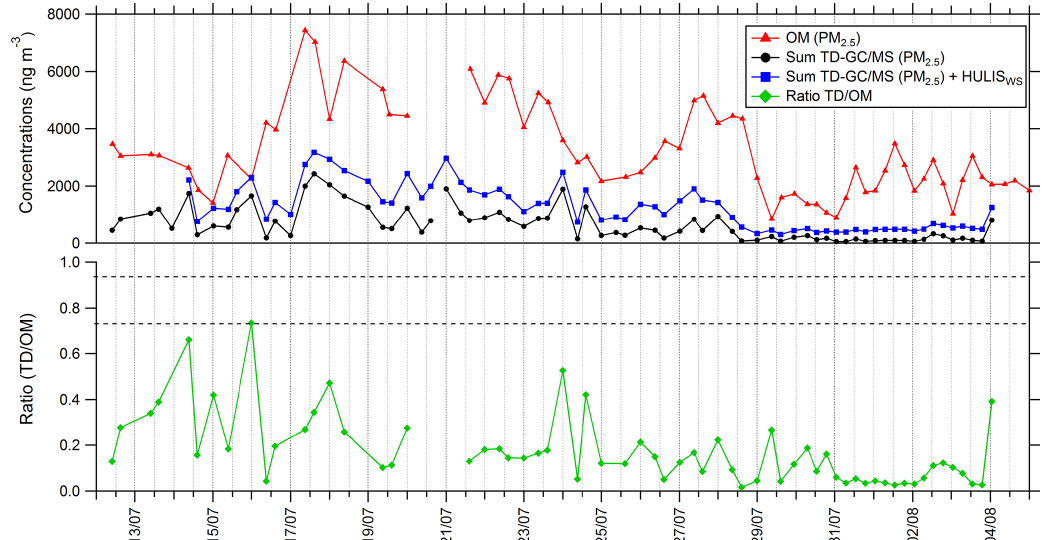
Figure 9. Time series of organic matter in PM 2 . 5 (red line), total sum of PM 2 . 5 from TD–GC–MS analysis (black line), total sum of PM 2 . 5 from TD–GC–MS analysis and water-soluble HULIS analysis (blue line), and ratio of these two measurements (green